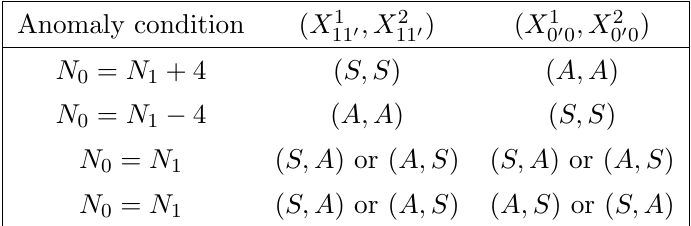
, all of them with gauge groups U( N 0 ) (cid:2) 2